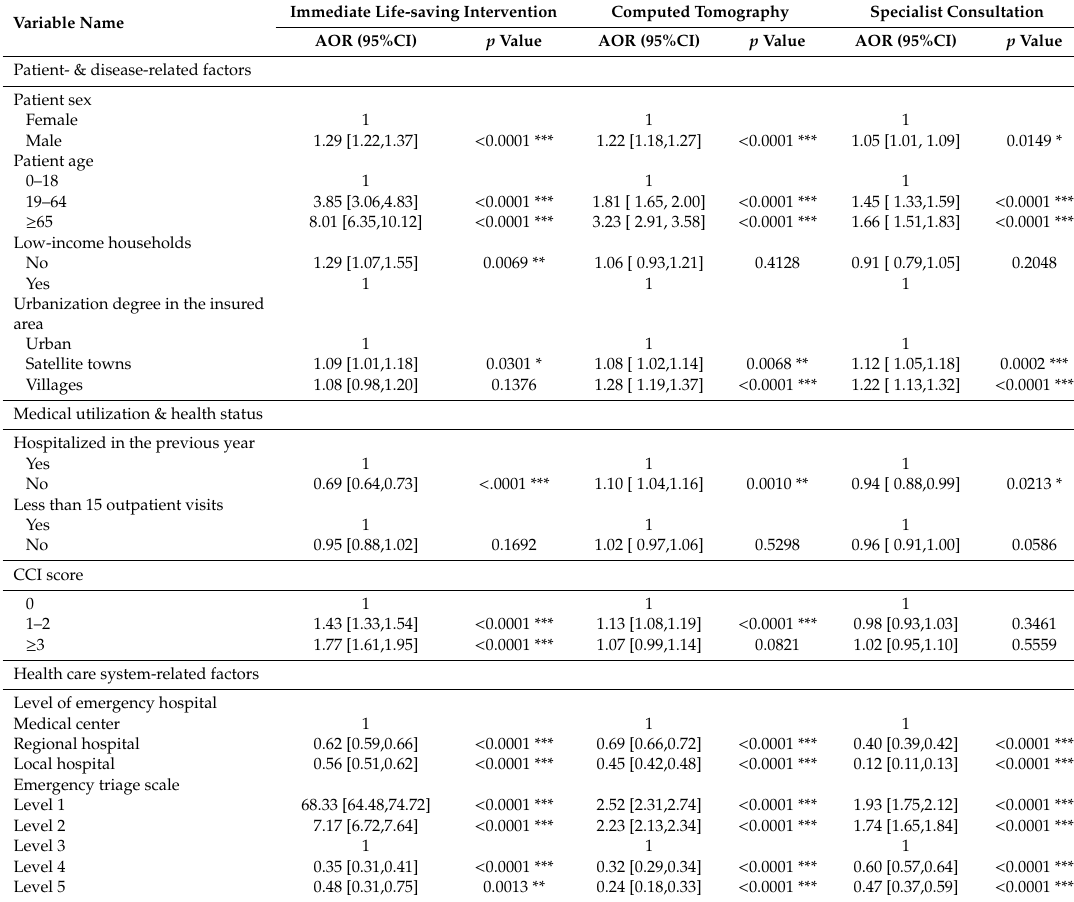
Table 2. Factors a ff ecting emergency medical treatment ( n =